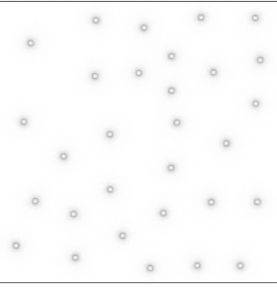
Figure 33. The position of 30 random points on the top plate of the structure.